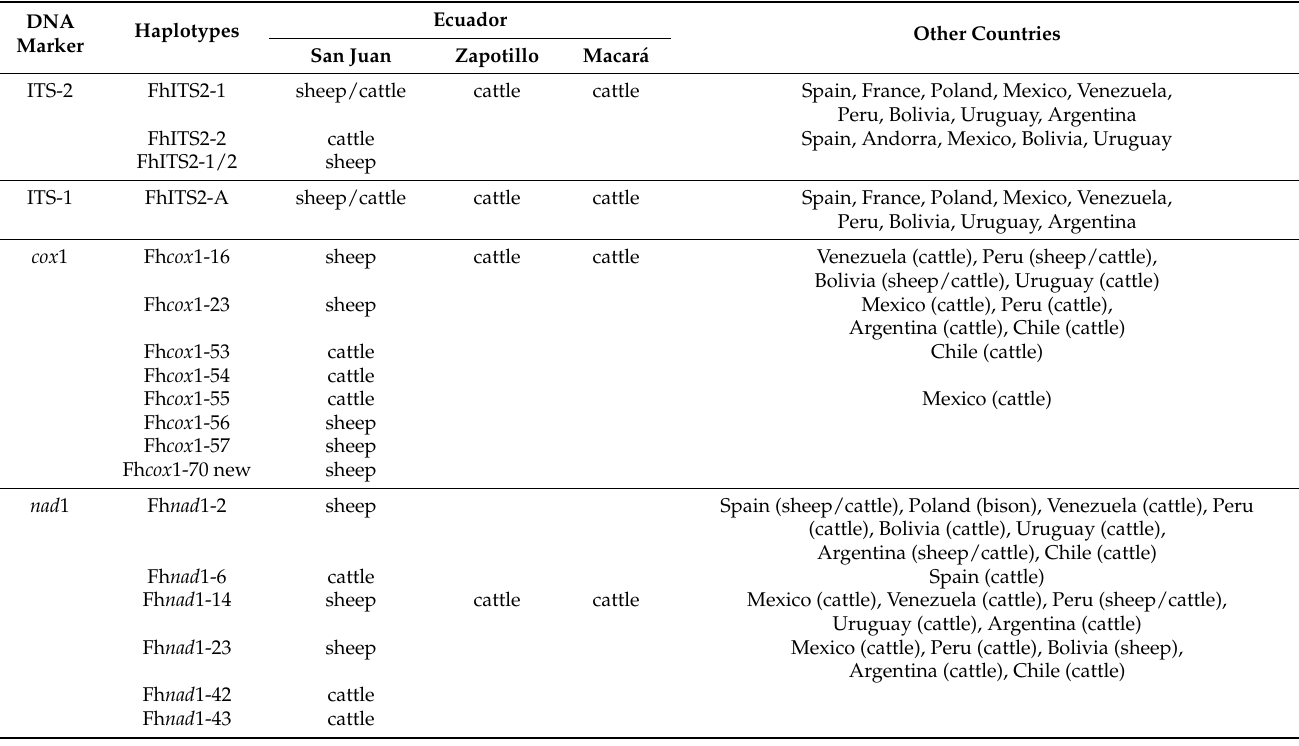
Table 7. DNA marker haplotypes distributed according to geographical origin, including comparison of Ecuador with other countries. Geographical data from other countries concern only complete sequences of each rDNA spacer and mtDNA gene. DNA